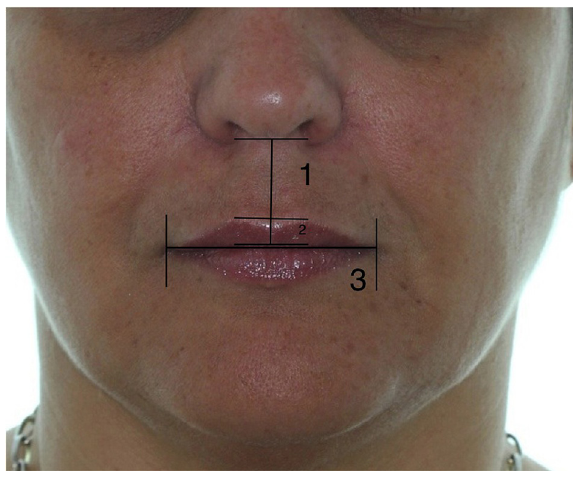
Figure 6. Measurements taken at rest. Figure 7. Measurements taken on